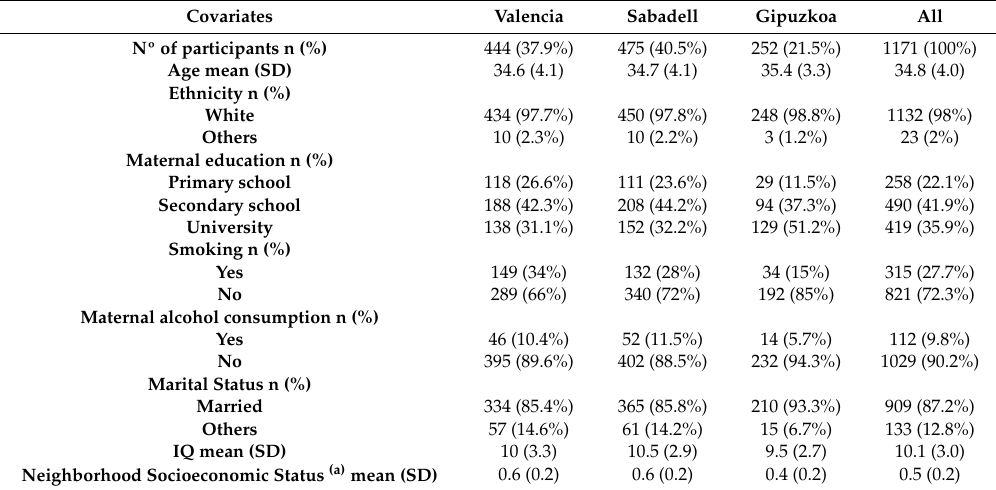
Table 1. Description of characteristics of the study participants separately by study